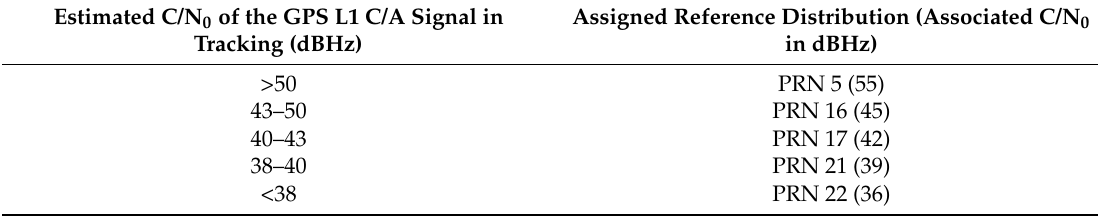
Table 5. GoF test method: assignment of the pre-computed GPS L1 C/A reference distribution functions to C/N 0 ranges of tracked